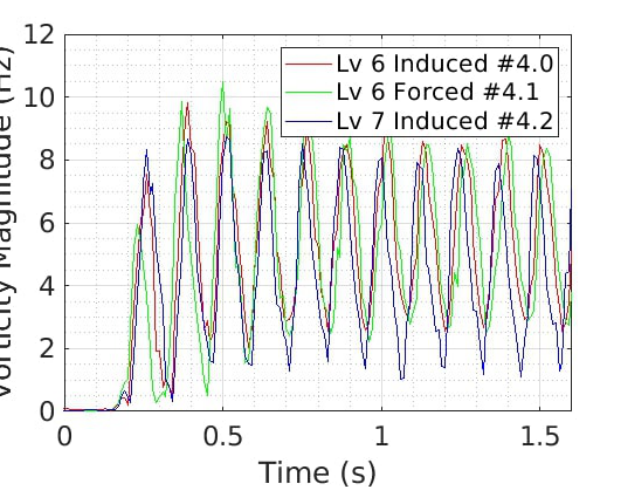
Figure 30. Time evolution of the vorticity magnitude at the probe position ( x ∗ = 1, y ∗ = 0.5) after phase shift correction for #4.0 (red line), #4.1 (green line) and #4.2 (blue line). To check if the signal was definitely the same, a fast Fourier transform was applied for the stabilized period from 0.3 to 1.6 s (Figure 31). For the horizontal axis turbine, the signal had a primary peak around 7.8 Hz. This peak corresponded to the passage of a tidal turbine blade upstream. The mesh refinement on the blades barely impacted the wake